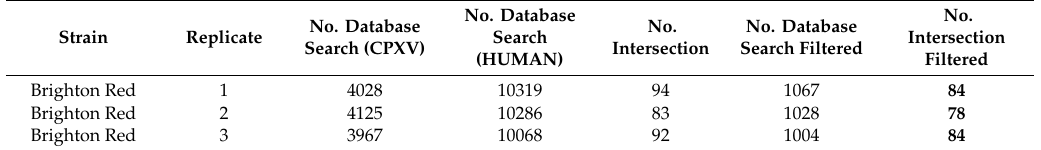
Table 5. This table shows the number of peptides from the cowpox virus (CPXV) Brighton Red strain after (i) database search with duplicates removed (CPXV); (ii) database search with duplicates removed (human); (iii) intersection of peptides obtained from Purple and peptide identifications from database search; (iv) database search, duplicates removed and filtered by 1% FDR threshold; and (iiv) intersection of peptides suggested by Purple and peptide identifications from FDR-filtered database search. The CPXV Brighton Red strain was compared against the background of all reviewed virus proteomes and was used for the database search.